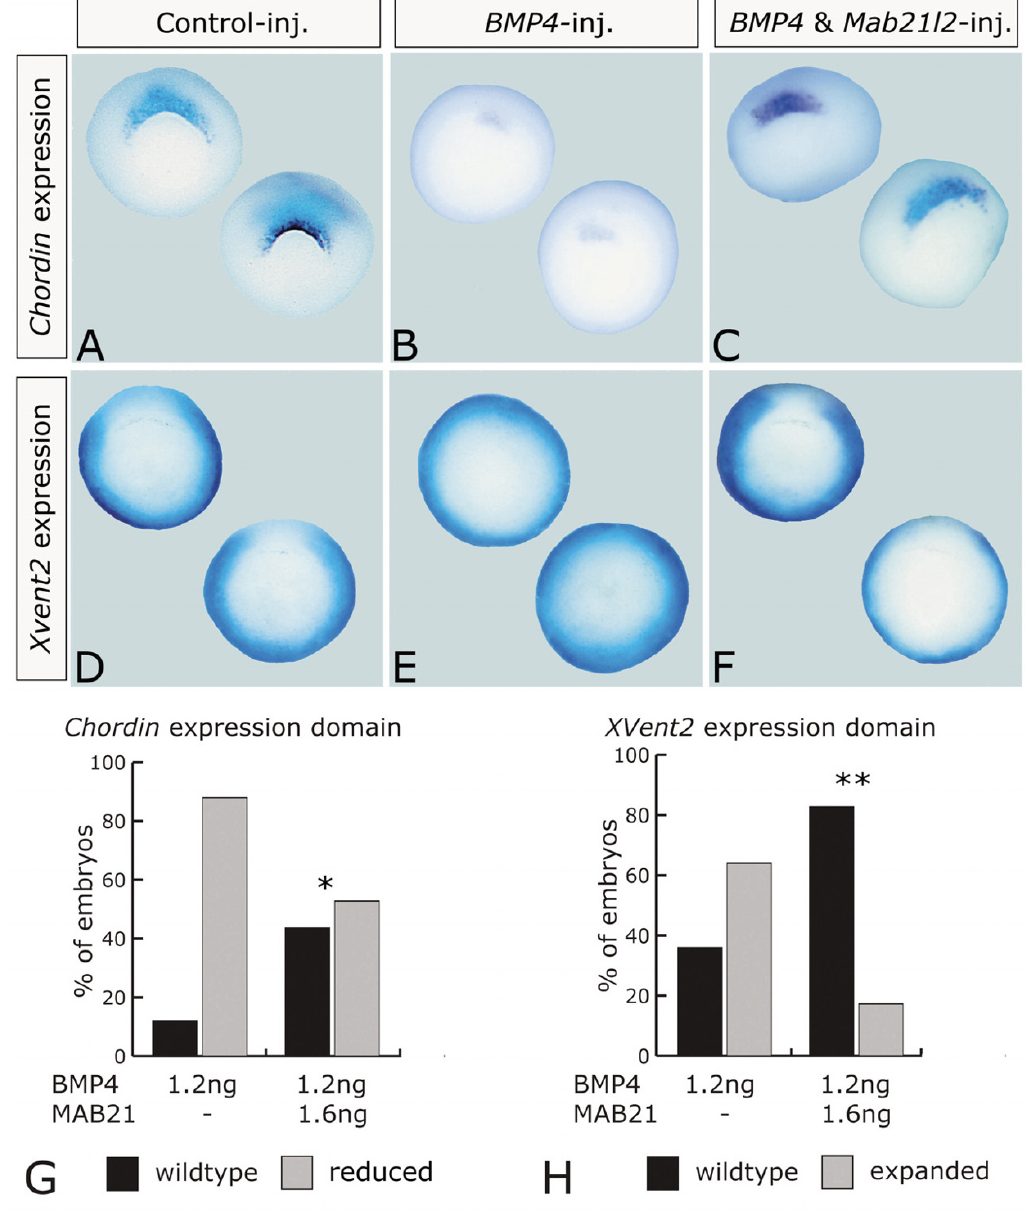
Figure 4 Xmab21l2 restores the normal expression of Xvent2 and Chordin in BMP4 -injected embryos. Chordin (A–C) and Xvent2 (D–E) expression were analyzed by whole mount in situ hybridization. Embryos are shown in a vegetal view, dorsal to the top, ventral to the bottom. (A, D) Wild type expression of Chordin (A) and Xvent2 (D) in stage 10.5 gastrulae; (B, E) embryos injected with 1.2 ng of BMP4 mRNA alone showed reduced Chordin expression (B) (22/25) and expanded Xvent2 expression (E) (16/25); (C, F) embryos co-injected with 1.2 ng of BMP4 and 1.6 ng Xmab21l2 mRNA showed a rescue of wild type Chordin (C) (17/36) and Xvent2 expression (F) (24/29). (G) Percentage of embryos exhibiting wild type (black bars) or reduced (grey bars) Chordin gene expression in embryos injected with 1.2 ng BMP4 alone, and in embryos coinjected with 1.6 ng Mab21l2 . Coinjection of Mab21l2 significantly increased the number of embryos exhibiting a wild type Chordin expression pattern; *: p = 0.004. (H) Percentage of embryos exhibiting wild type (black bars) or expanded (grey bars) Xvent2 gene expres- sion in embryos injected with 1.2 ng BMP4 and in embryos coinjected with 1.6 ng Mab21l2 . Again, Mab21l2 significantly increased the number of embryos exhibiting a wild type Xvent2 expression pattern; **: p = 0.00044. Statistical analysis was con- ducted using the Chi square algorithm (1 df